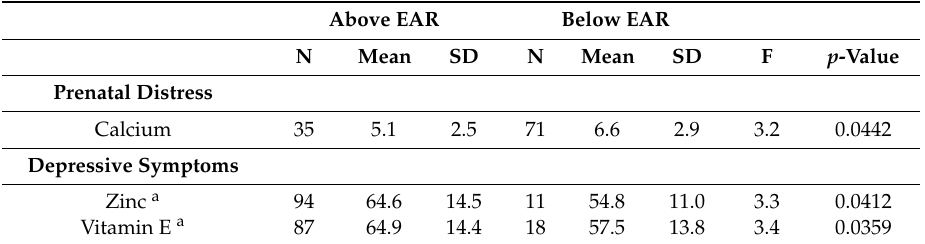
Table 4. Difference in prenatal distress, depressive symptoms, and social support between adequate and inadequate micronutrient